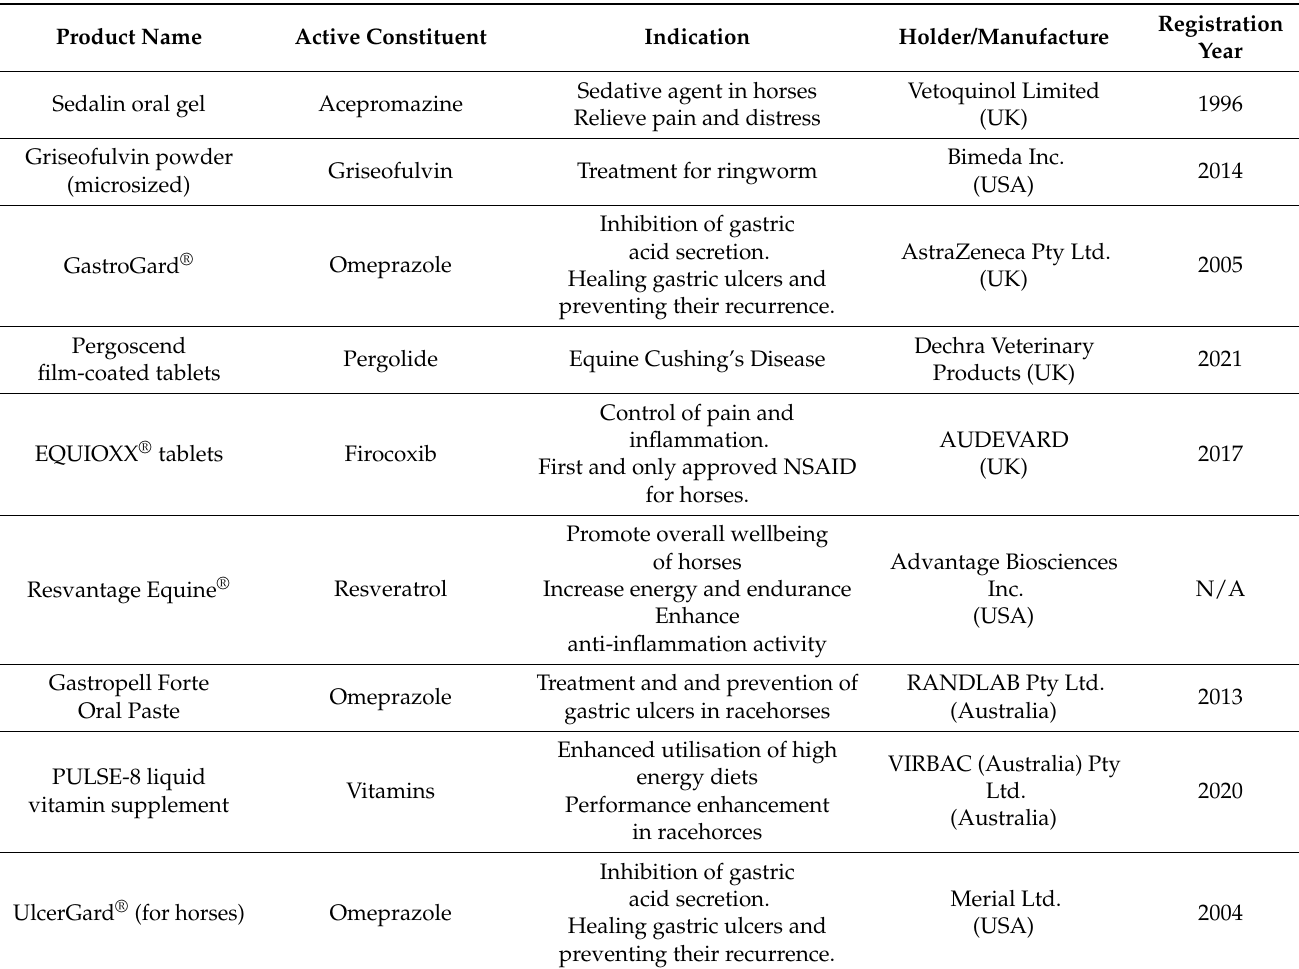
Table 3. Examples of Marketed/Registered equine oral products and their